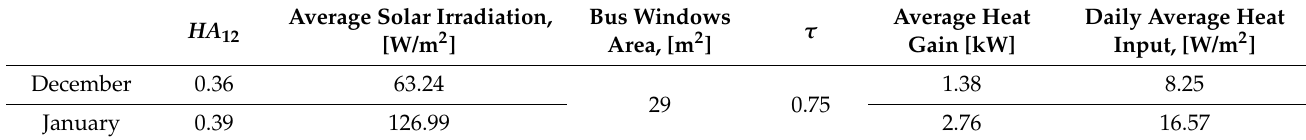
Table 2. Average heat gain for both direct and diffused solar